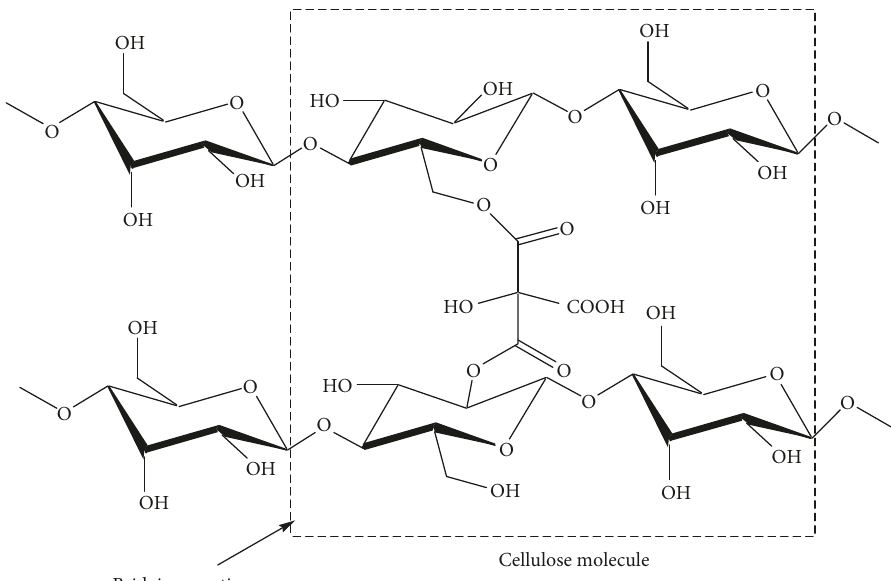
Figure 2: Reaction between citric acid and cellulose molecules [45].